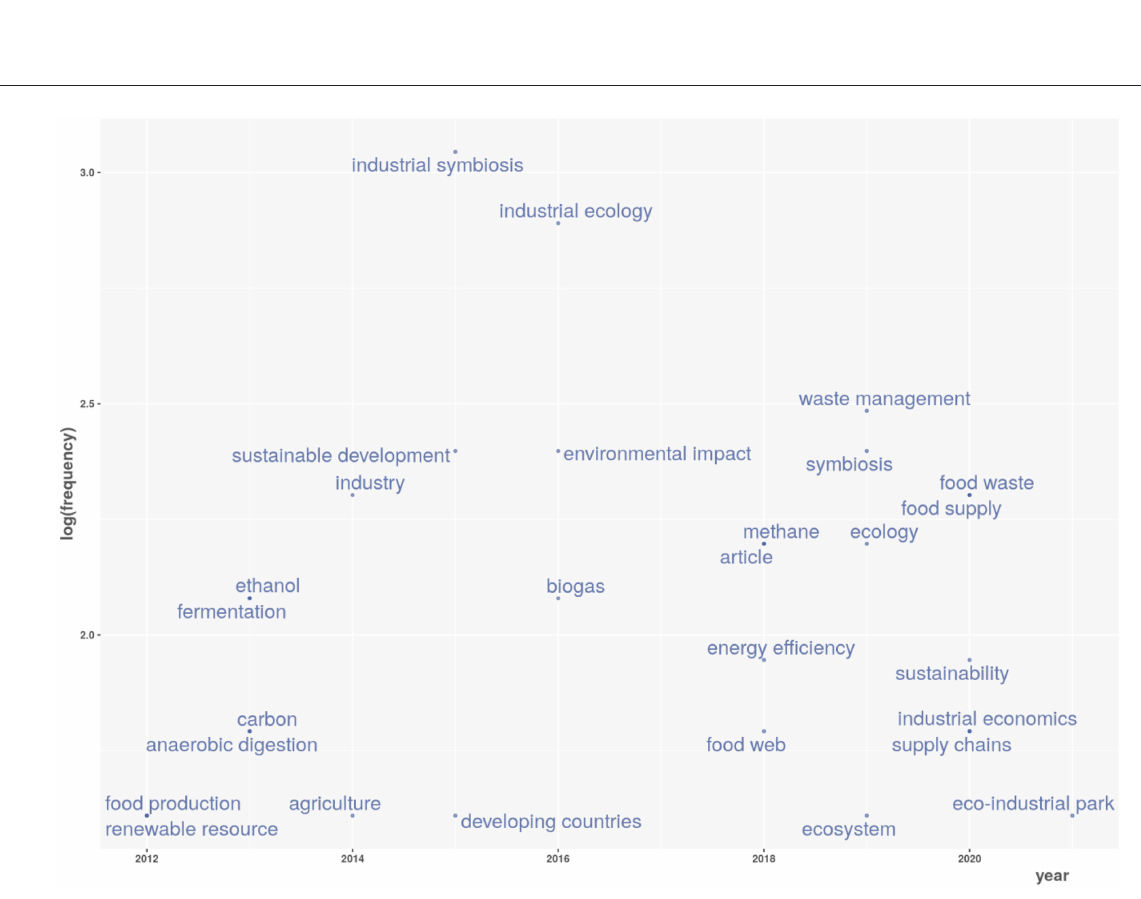
FIGURE4 Trend keywords in the last 10 years. Source: our elaboration using “bibliometrix” R